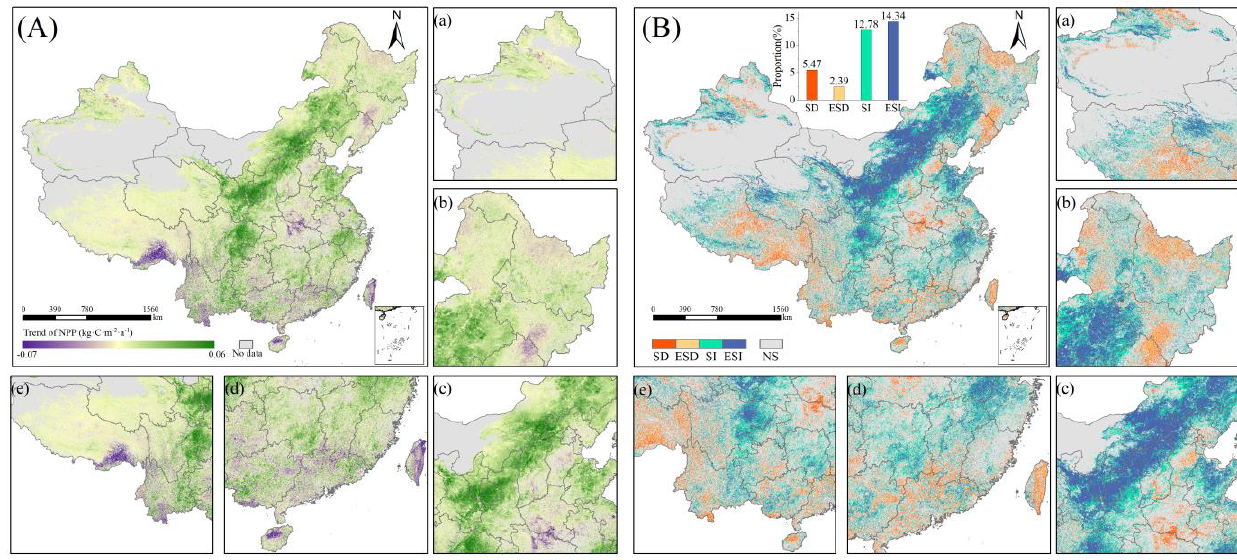
Figure 4. ( A ) Temporal trends of NPP in China between 2000 and 2020 and ( B ) the spatial distribution of significant ( p < 0.05) and very significant ( p < 0.01) trends for NPP variation. SD, decreased significantly; ESD, decreased very significantly; SI, increased significantly; ESI, increased very significantly. ( a – e ) represent the detailed information for the northwest China, northeast China, Central China, southeast China and southwest China,